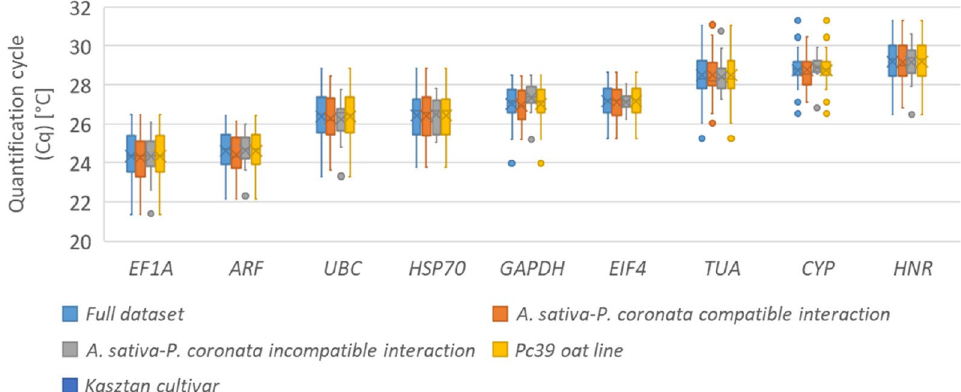
Figure 1. Cq values for nine candidate reference genes (ARF (ADP-ribosylation factor), CYP ( cyclophilin), EF1A (elongation factor 1-alpha), EIF4A (eukaryotic initiation factor 4A-3), GAPDH (glyceraldehyde-3- phosphate dehydrogenase), HNR (heterogeneous nuclear ribonucleoprotein 27C), HSP70 (heat shock protein), TUA (alpha tubulin), and UBC (ubiquitin conjugating enzyme (E2)) across experimental samples. A line across the box is depicted as the median. The box indicates the 25th and 75th percentiles, the dots represent outlier values.